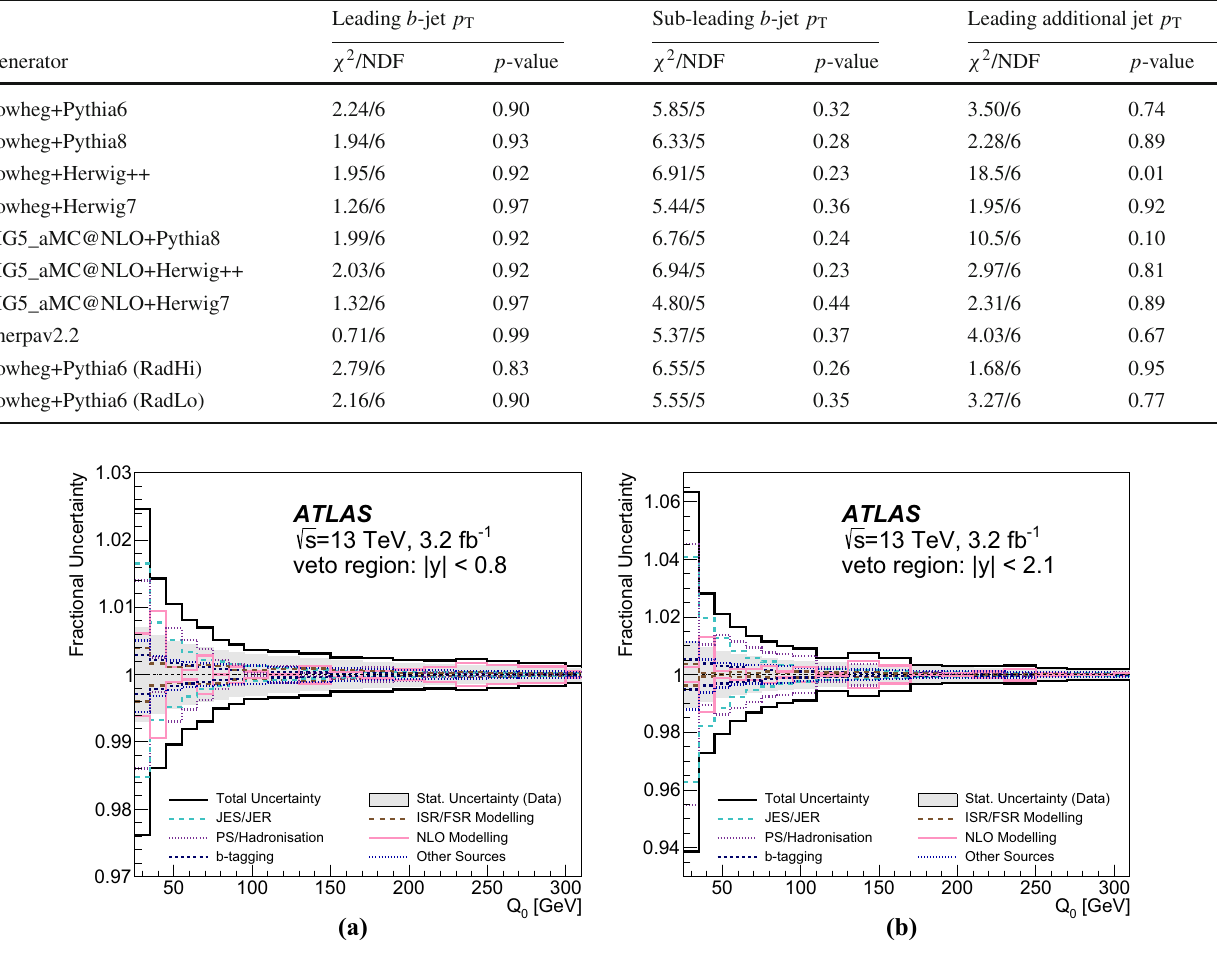
Fig. 8 Envelope of fractional uncertainties (cid:6) f / f in the gap fraction f part gap ( Q 0 ) , centred around unity, for a | y | < 0 . 8 and b | y | < 2 . 1. The statistical uncertainty is shown by the shaded area , and the total uncer-